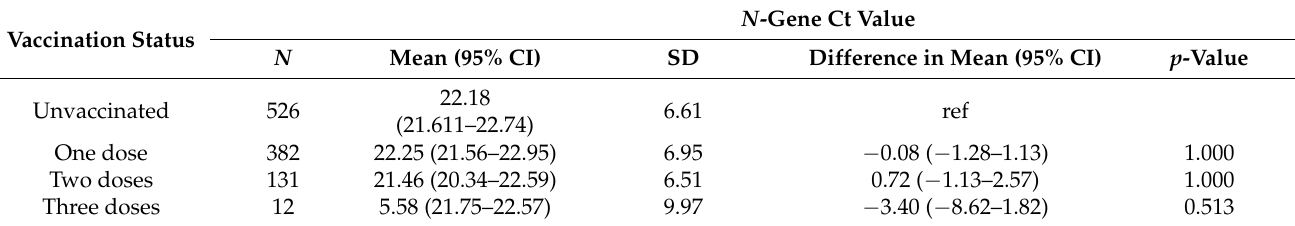
Table 2. The impact of vaccines on reducing viral